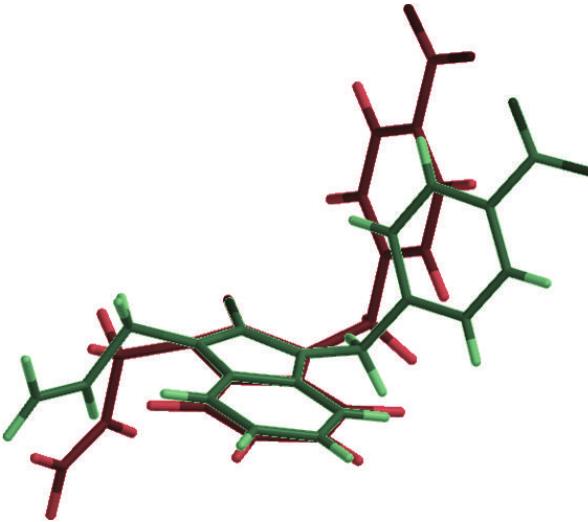
Figure 3: Superimposed structures: optimized at PM3: red; X-ray: green.